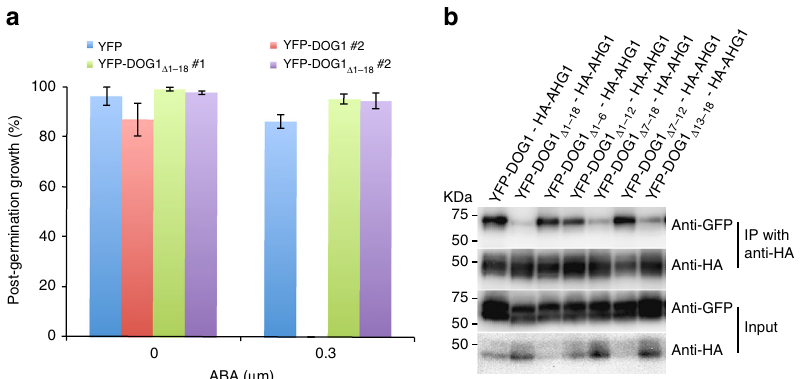
Fig. 6 Physical interaction of DOG1 with AHG1 affects DOG1 function. a Post-germination growth ef fi ciencies of overexpressing YFP-DOG1 Δ 1 – 18 , YFP-DOG1, and control YFP lines were treated with or without 0.3 μ M ABA at 7 days after strati fi cation. Error bars show s.d. of three independent experiments using the same seed batch. b Interaction of the N-terminal portion of DOG1 with AHG1. HA-AHG1 co-immunoprecipitates with the deleted forms of YFP-DOG1. Total protein extracts from transformed N. benthamiana leaves were harvested 5 days after inoculation. After co-immunoprecipitation using anti-HA matrix, the input and the immunoprecipitated samples were detected with anti-GFP and DOG1 Δ 1-18 (Supplementary Fig. 11b). In the transgenic Arabi-